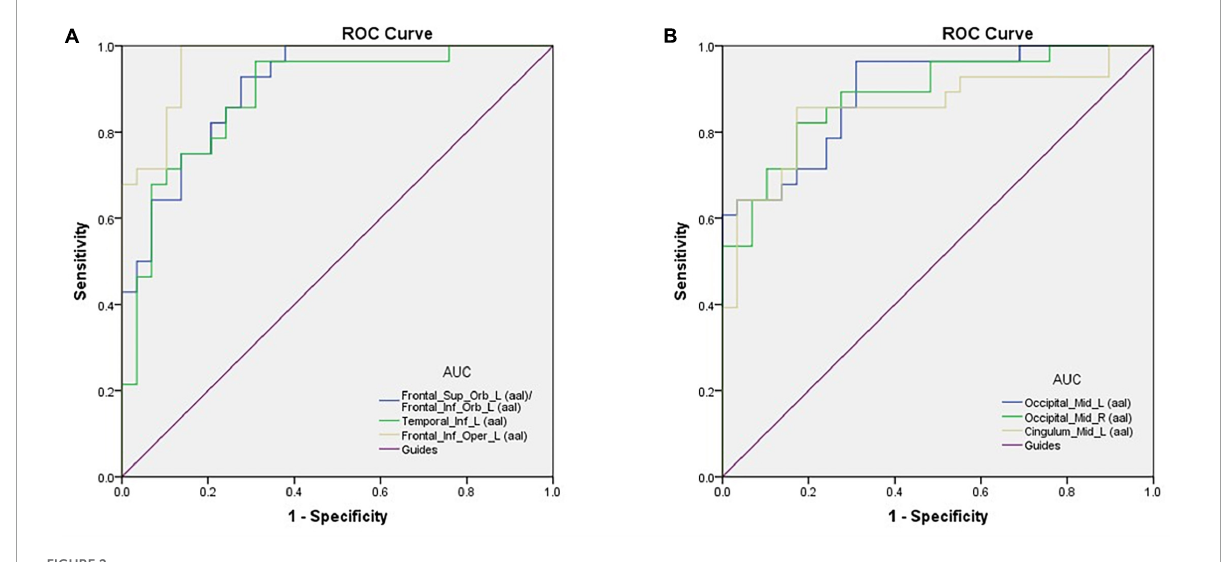
FIGURE2 ROC curve analysis of the mean perAF values for altered brain regions. (A) The area under the ROC curve was 0.904, ( p < 0.0001; 95% CI: 0.830–0.978) for Frontal_Sup_Orb_L (aal)/Frontal_Inf_Orb_L (aal); Temporal_Inf_L (aal) 0.883, ( p < 0.0001; 95% CI: 0.794–0.972); Frontal_Inf_Oper_L (aal) 0.964, ( p < 0.0001; 95% CI: 0.924–1.000). (B) The area under the ROC curve was 0.893 ( p < 0.0001; 95% CI: 0.812–0.973) for Occipital_Mid_L (aal); Occipital_Mid_R (aal) 0.887, ( p < 0.0001; 95% CI: 0.802–0.971); Cingulum_Mid_L (aal) 0.855, ( p < 0.0001; 95% CI: 0.750–0.960). AUC, area under the curve; ROC, receiver operating